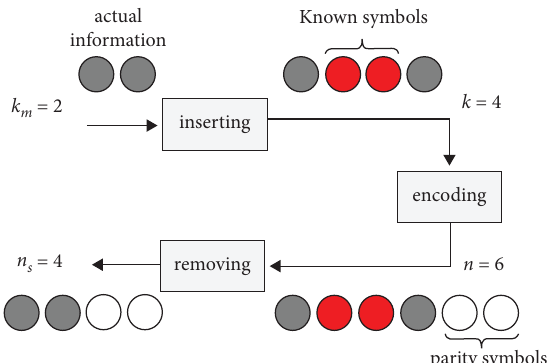
Figure 3: Te example of the shortening process at the transmitter.